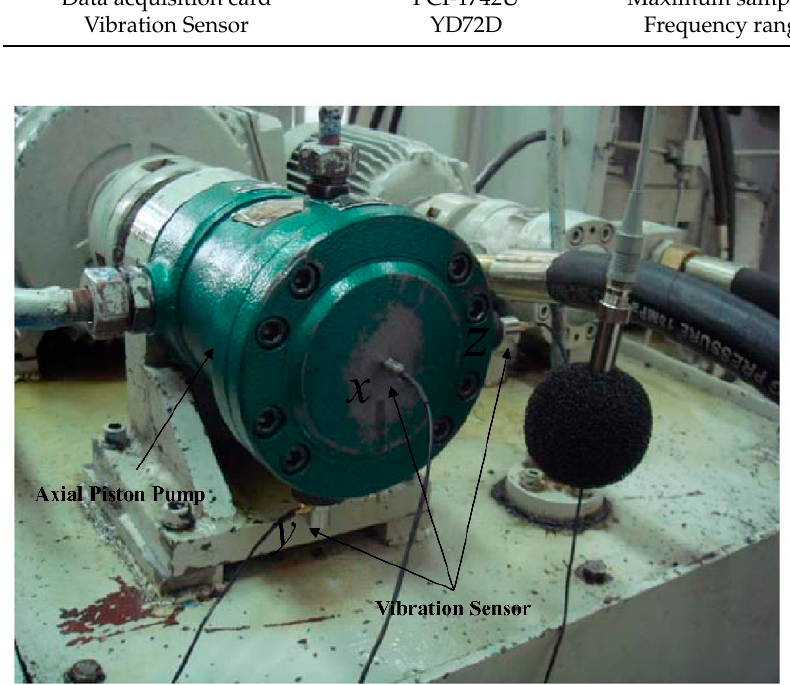
Figure 14. Axial piston pump failure simulation test bench and sensor layout.